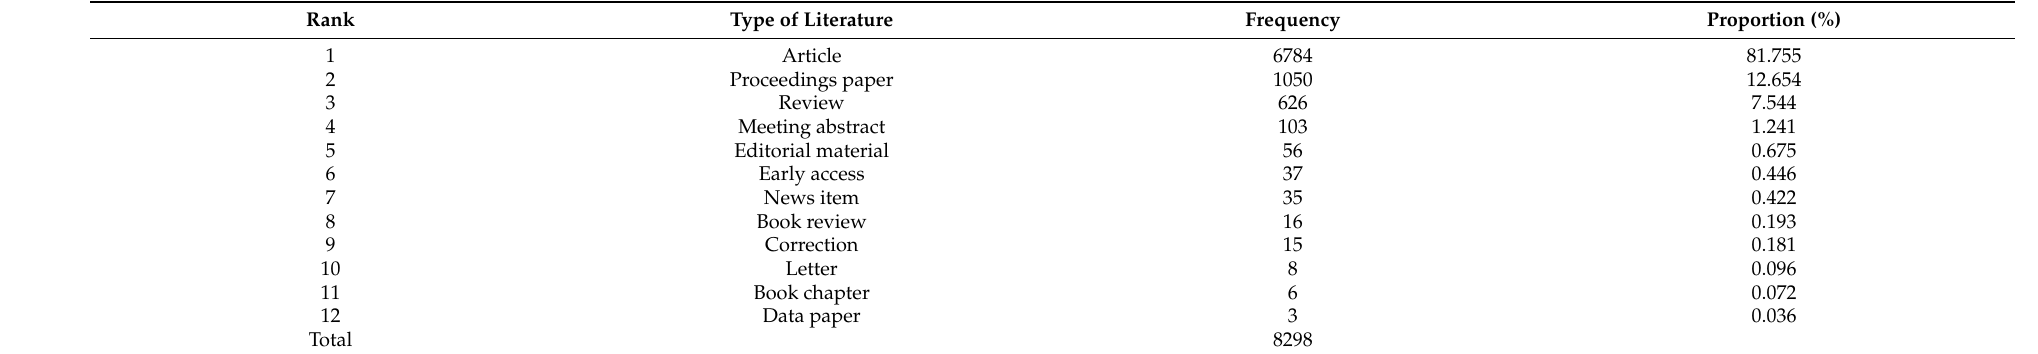
Table A1. Types of literature in FW studies.